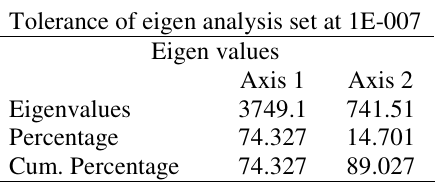
Table 10. Principal components